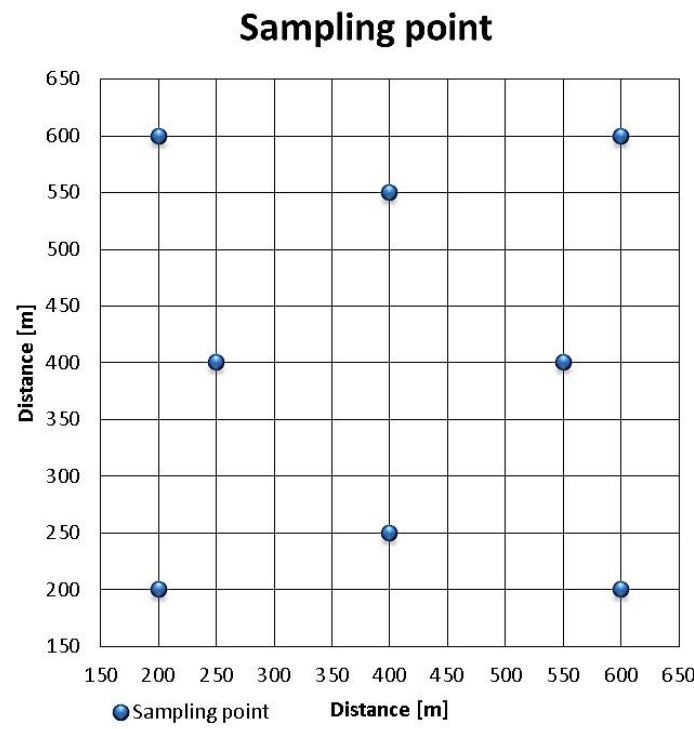
Figure 1. Plan of collecting materials for analysis from different sampling